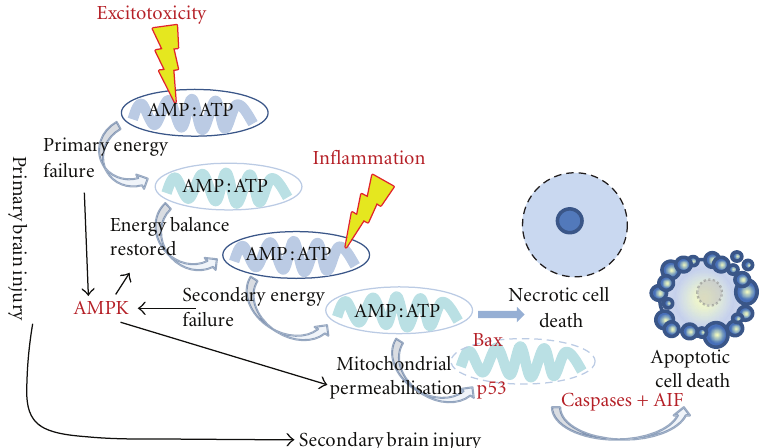
Figure 2: The development of secondary brain injury. Energy depletion culminating in Bax-dependent mitochondrial permeabilisation represents an irreversible commitment to cell death in neonatal brain